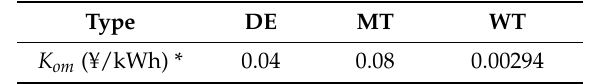
Table 2. Operation and maintenance coefficients of distributed generations (DGs).